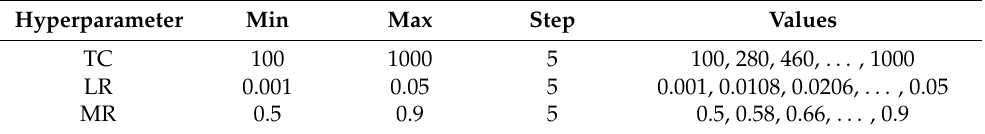
Table 3. First grid search for ANN hyperparameters.